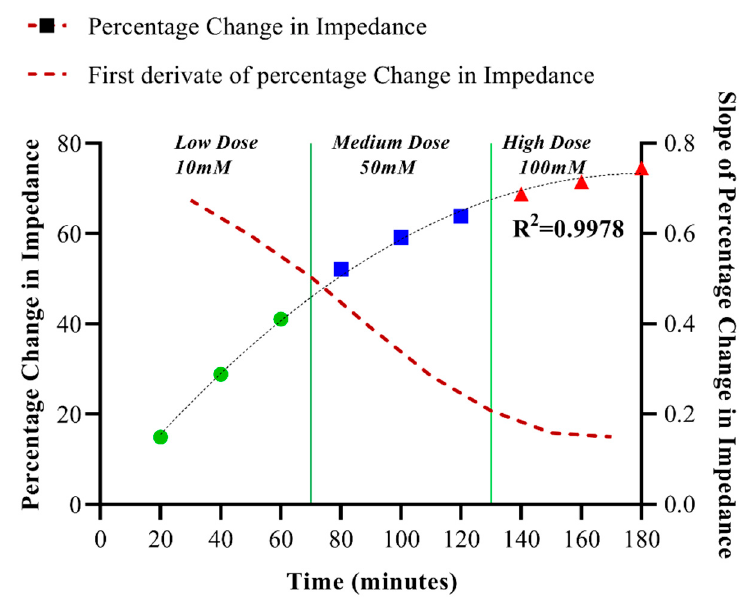
Figure 6. The continuous chloride monitoring capability of the sensor was evaluated by successively dosing with low, medium, and high chloride solutions (3 µ L) for a duration of 180 min. Dose-dependent response (R 2 = 0.9978) was obtained, and the first derivative of the response indicates that the sensor does not saturate even after 3